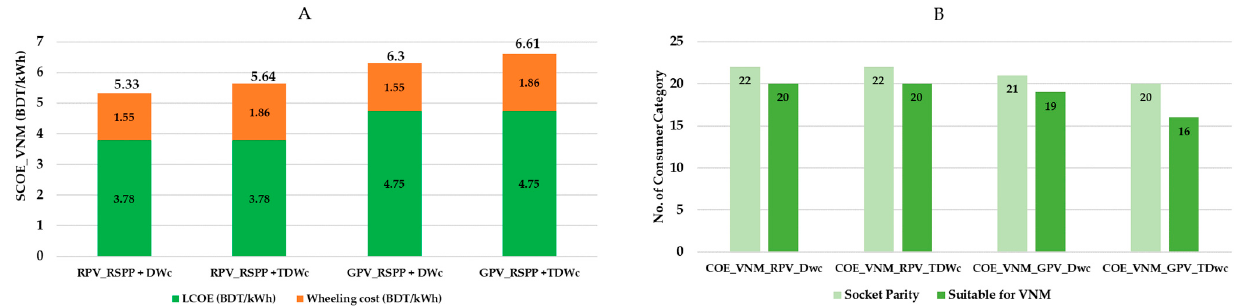
Figure 5. Socket cost of VNM electricity ( SCOE VNM ) and socket parity by number of consumers. ( A ) The sums of LCOEs and wheeling costs, and ( B ) the number of consumer categories that meet socket parity and are suitable for VNM.